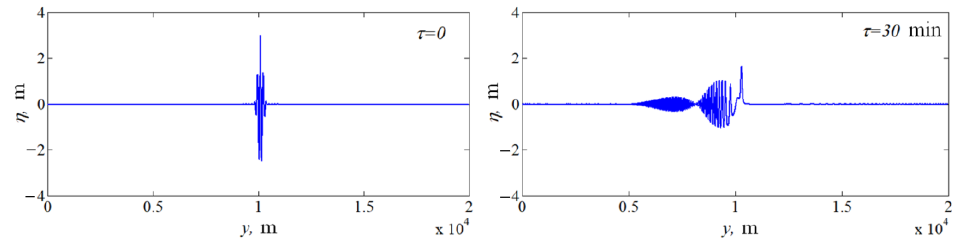
Figure 9. The transformation of impulses of different shapes.